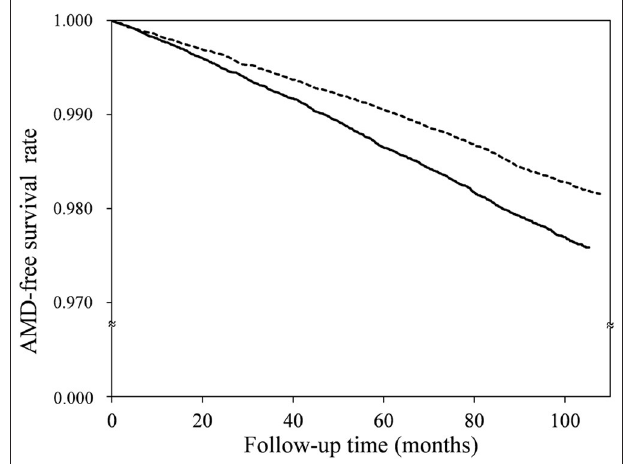
FIGURE 2 | Age-related macular degeneration (AMD)-free survival rates for the osteoarthritis (solid line) and non-osteoarthritis (dotted line) groups.